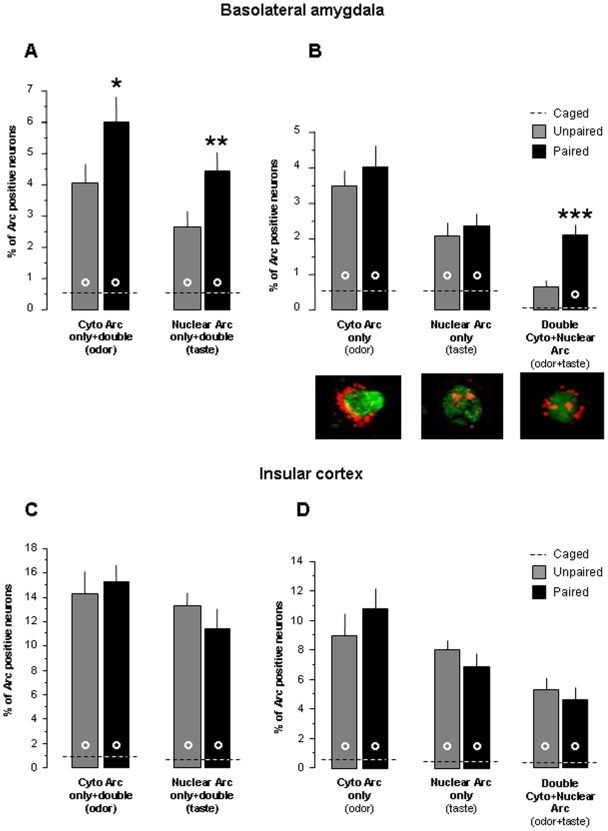
Flavor experience increase odor-taste convergence in basolateral amygdala but not in insular cortex.Percentage of Arc positive neurons in the basolateral amygdala (A,B) and in the insular cortex (C,D) after odor and taste presentations. Cytoplasmic responses correspond to the odor stimulation and nuclear responses correspond to the taste stimulation in the Paired and the Unpaired groups. Data are represented as means ± SEM. ***, **, *: different from the Unpaired group (p<0.001; p<0.01; p = 0.057). °: different from the Caged group (p<0.01).